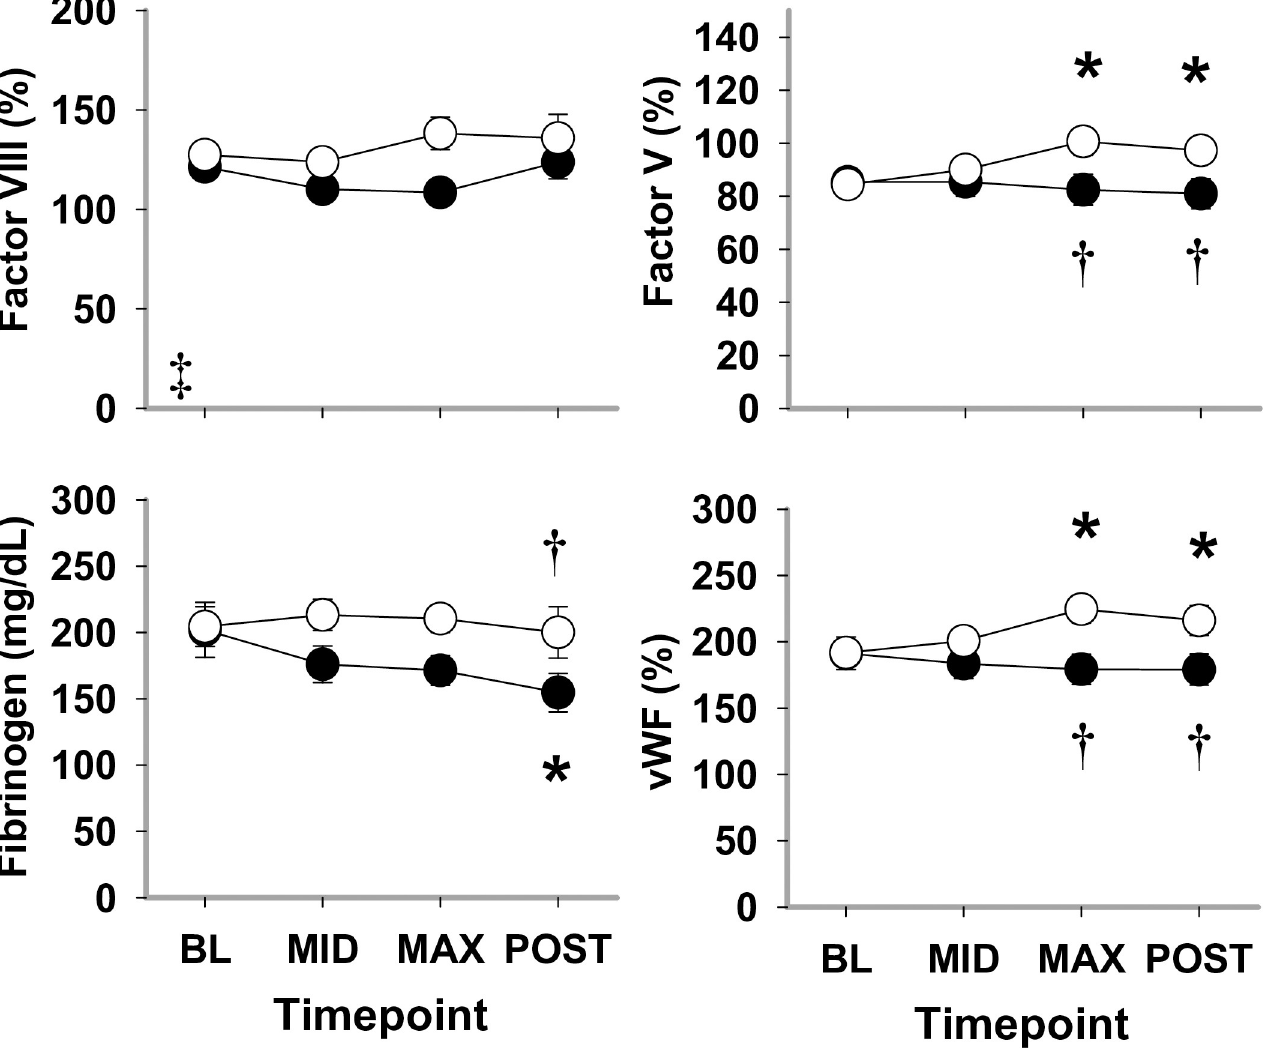
Fig 4. Plasma pro-coagulation factors VIII and V, fibrinogen, and von Willebrand factor antigen (vWF:Ag) during HEM and LBNP in anesthetized baboons. Mean ± SE, n = 11–13; � different from baseline ( P < 0.05); and † different from HEM ( P < 0.05).